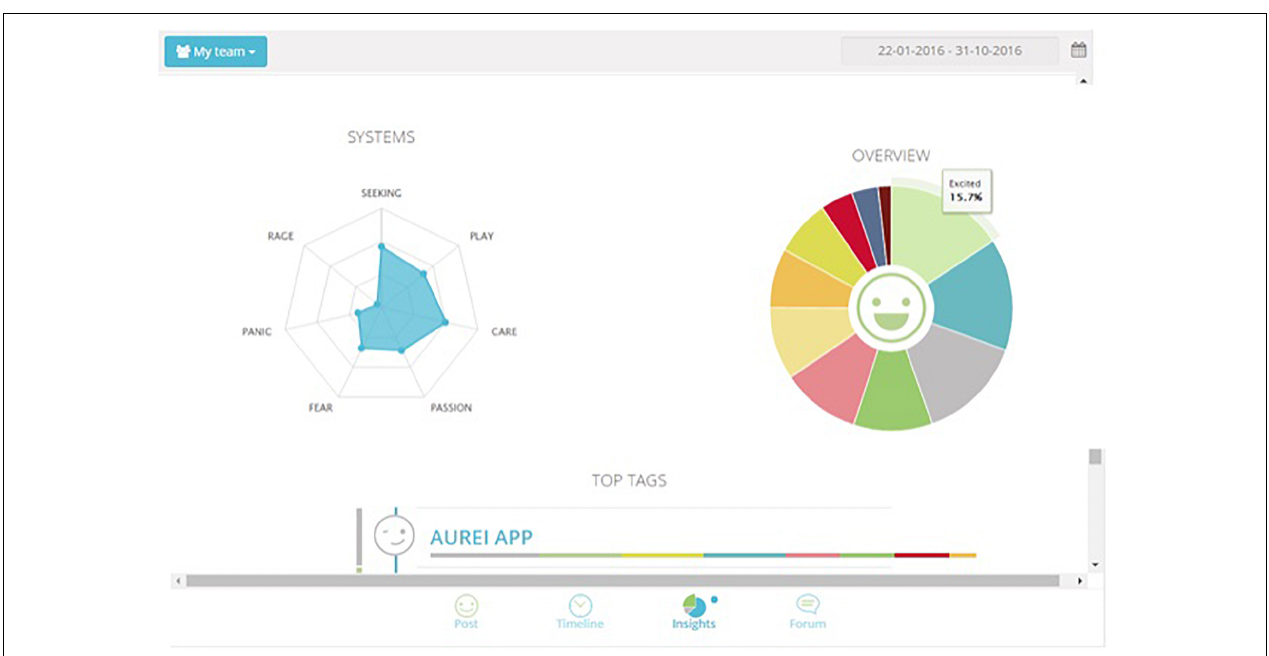
FIGURE 2 | Team collected data. The cumulative percentages of choice of emotions made by a team are represented in the pie chart (Different colors match to the different emotions as they are displayed in Figure 1 ) while the web graph shows the correspondence between chosen emotions and emotional systems.